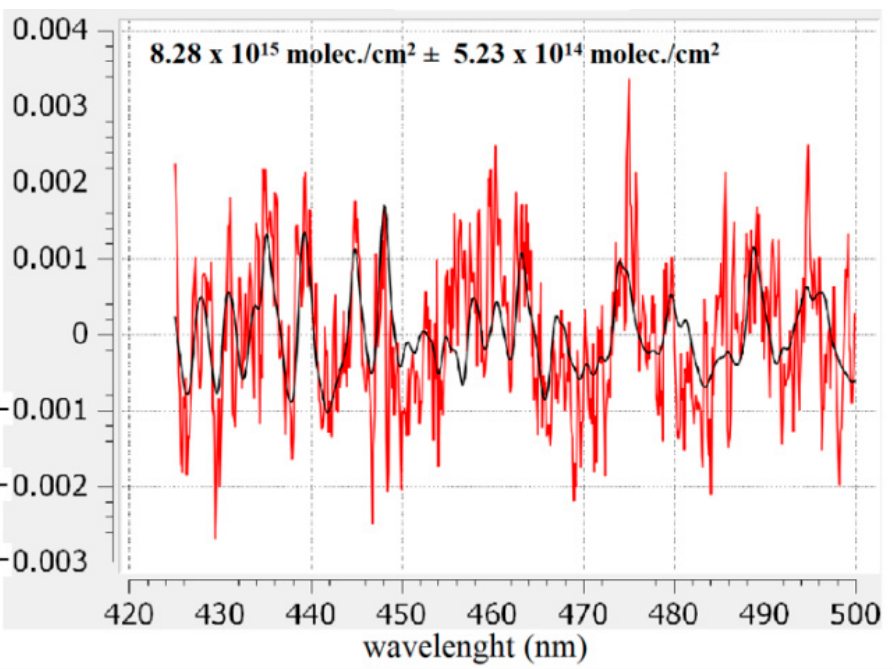
Figure 2. Example of a NO 2 spectral fitting using QDOAS on a spectrum retrieved on 11 February at 11:28 a.m. in Galati city. The black line corresponds to molecular cross-sections scaled to the detected absorptions in the measured spectrum (red line). (molec. represent molecules).